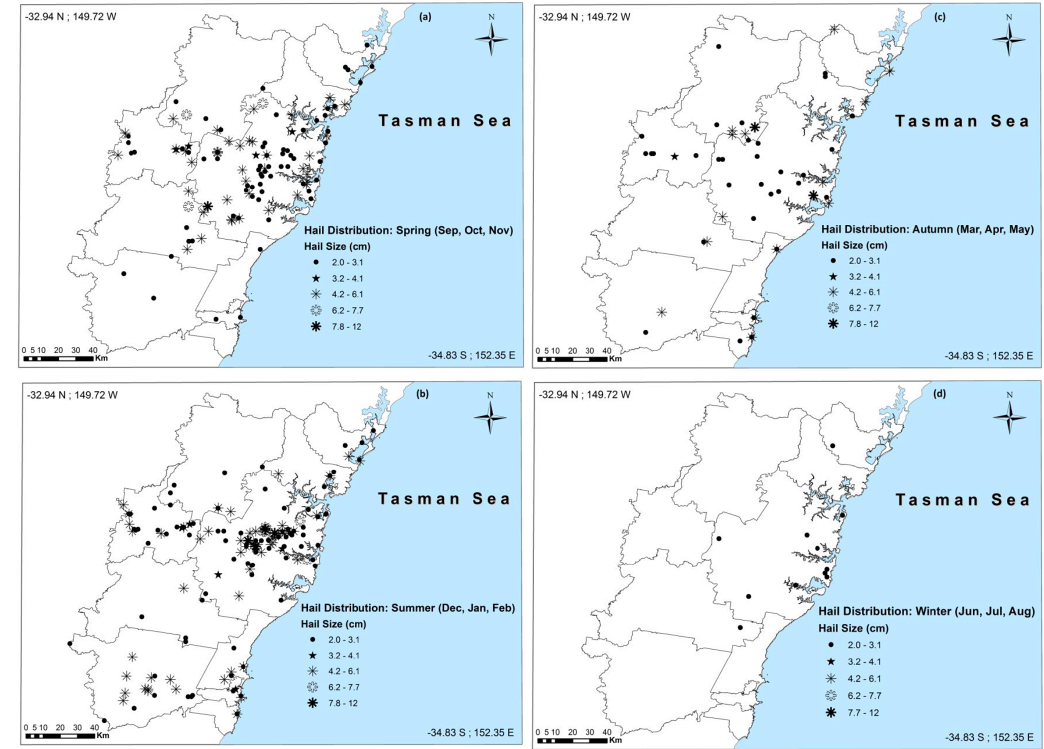
Figure 8. Seasonal distribution of hail events during (a) spring, (b) summer, (c) autumn and (d)